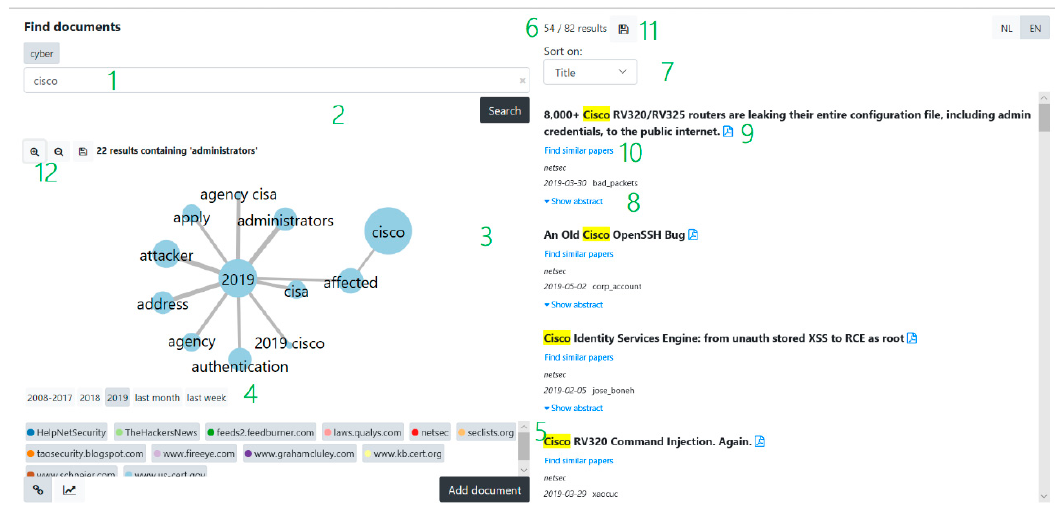
Figure 3. Result screen of the Horizon Scanner tool with the entity graph.